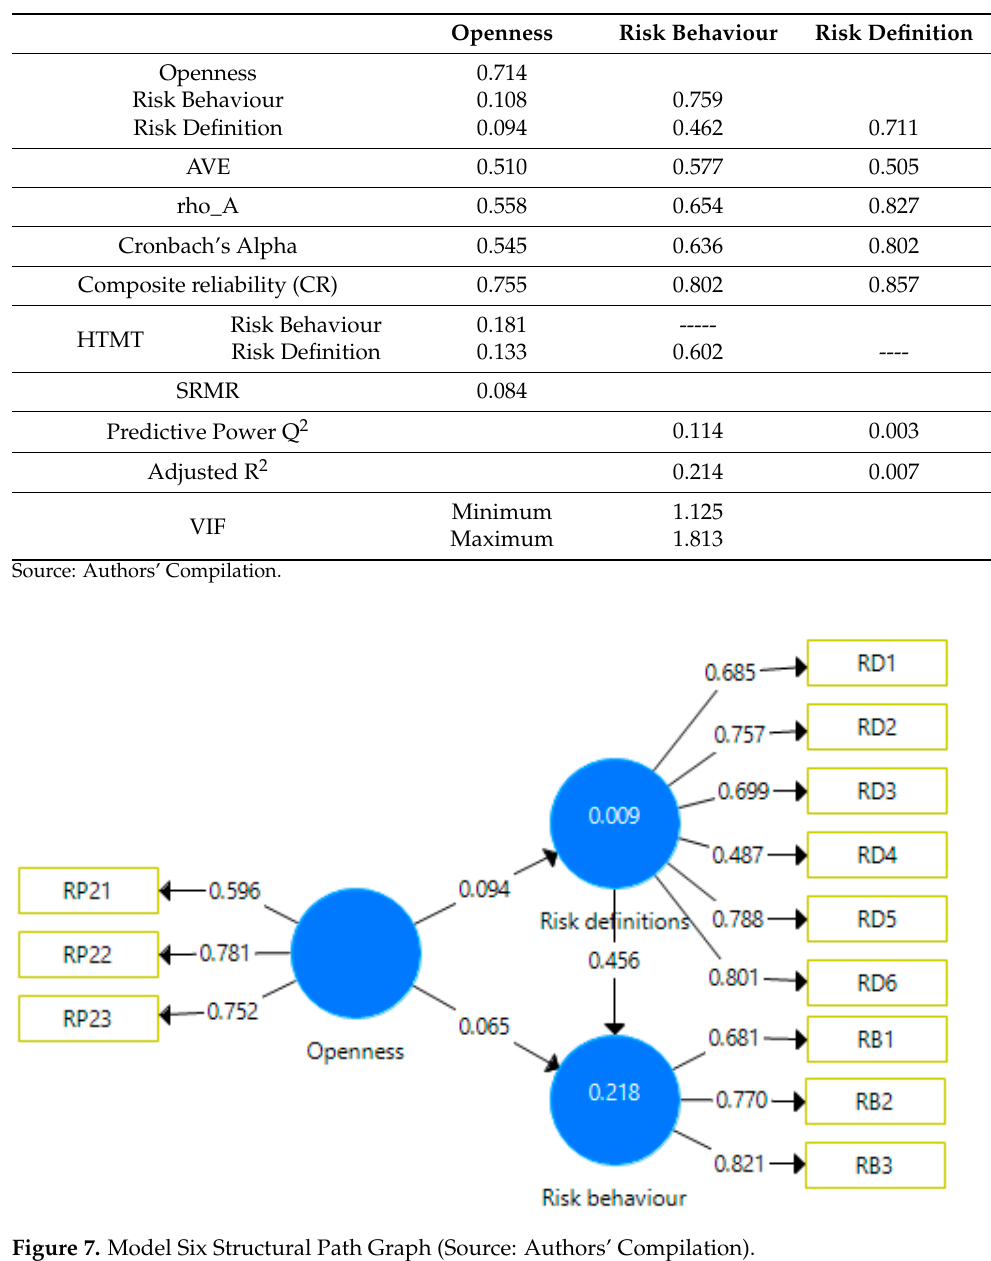
Table 9. Evaluation of Reflective Measurement Models and Structural Models for Model Six.